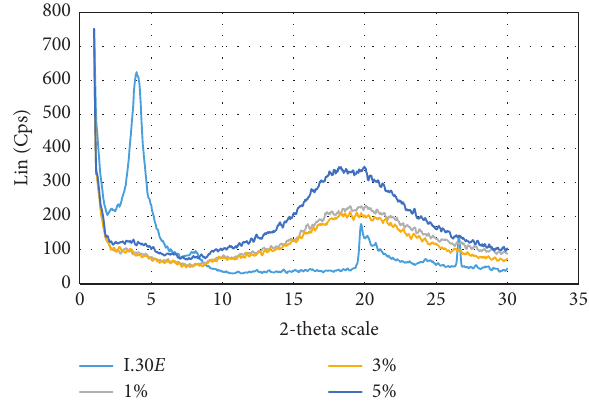
Figure 3: XRD diagram of materials I.30E; nanocomposite:1 wt.%, 3 wt%, and 5 wt.%